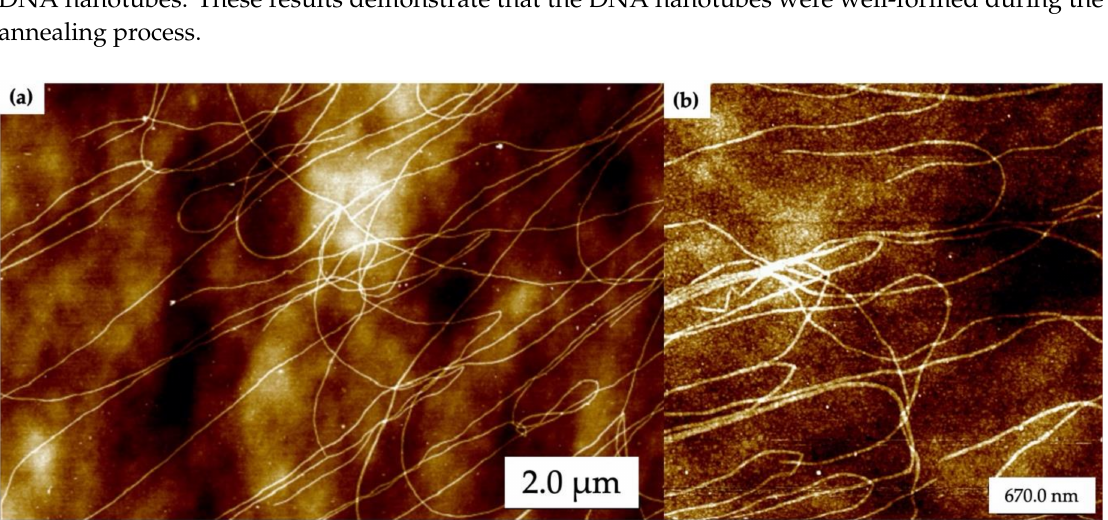
Figure 2. Atomic force microscopy (AFM) images of self-assembled DNA nanotubes. ( a ) Large area and ( b ) zoomed in images. Height scale is 8 nm.